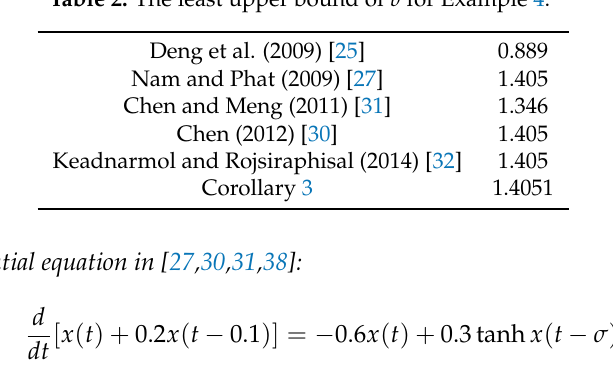
Table 2. The least upper bound of b for Example 4.